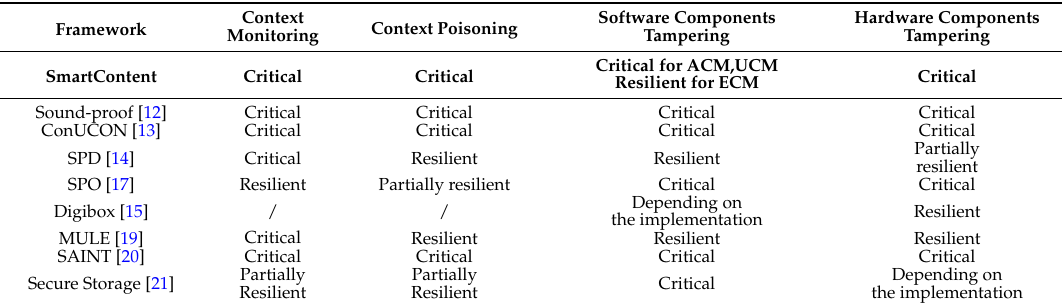
Table 2. Comparison of attacks for the cited security